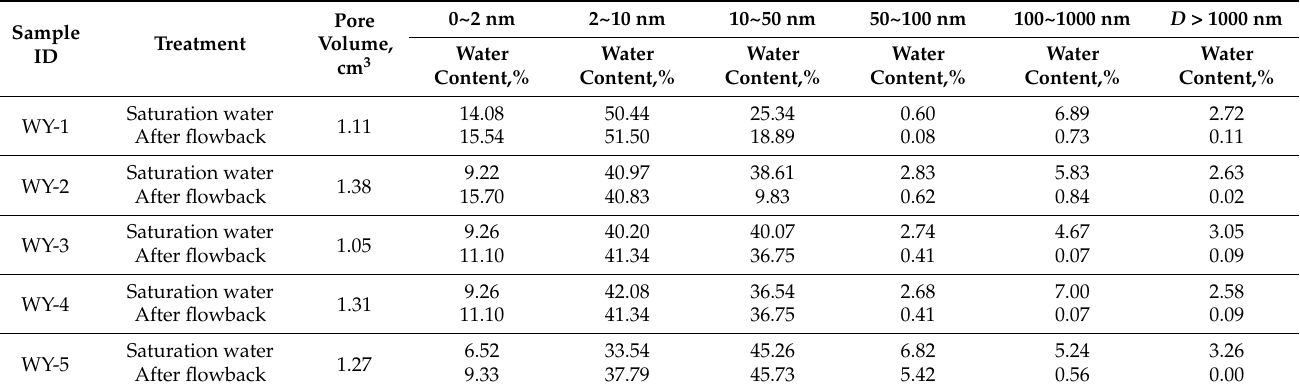
Table 5. Distribution characteristics of saturated water and after flowback water phase in shale multiscale pore